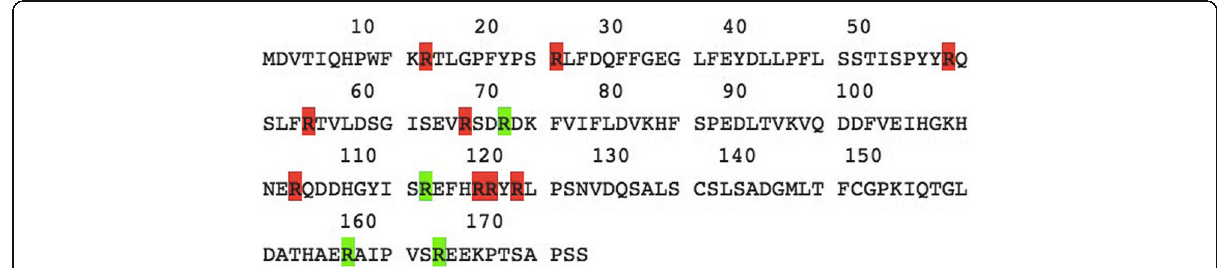
Fig. 7 Protein sequence of α A-crystallin. There are 13 arginine residues (red or green) in human α A-crystallin. Nine of these 13 arginine residues (red) are hot spots for mutations, which eventually lead to congenital